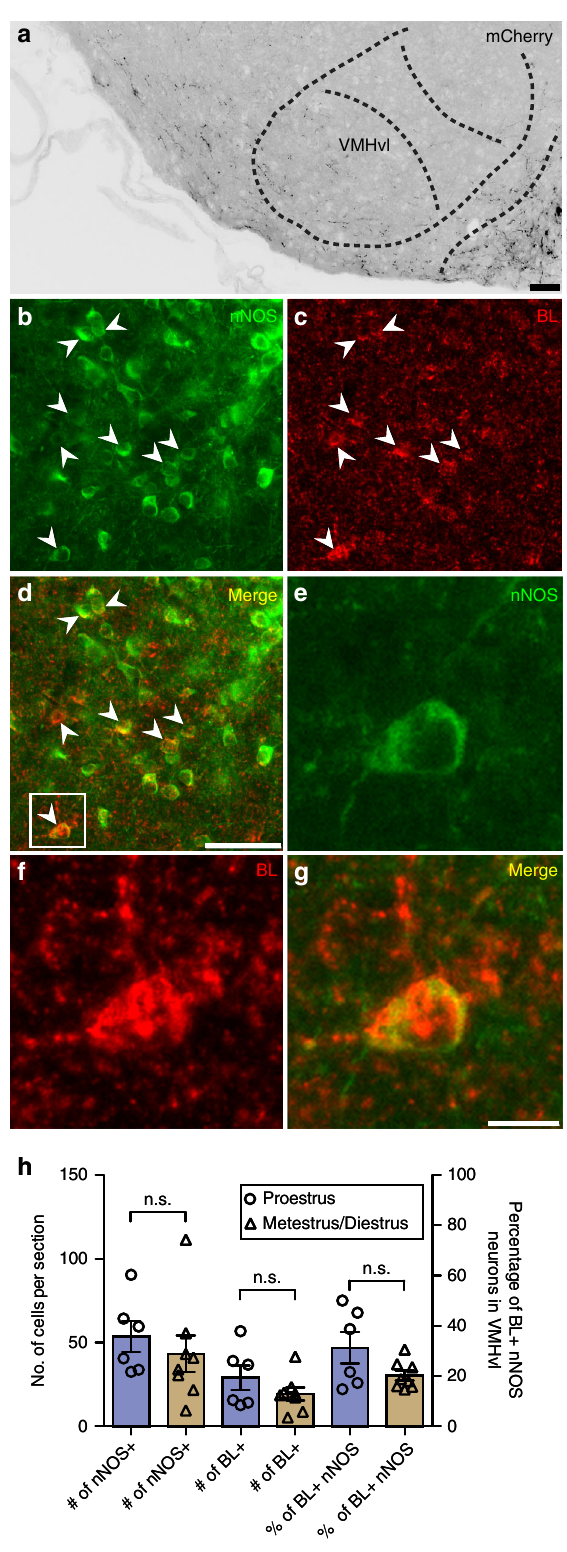
neurons project to the VMHvl and therefore, these VMHvl nNOS neurons may be downstream of RP3V kisspeptin neurons. We observed at proestrus that 31.27 ± 6.22% of nNOS neurons in the VMHvl were BL+, whereas at diestrus 20.25 ± 1.94% contained the tracer, however this was not found to be statistically